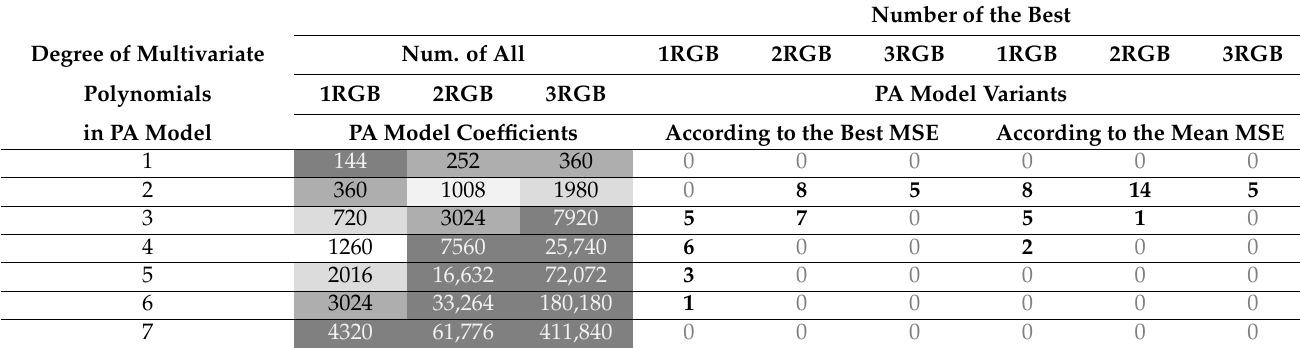
The number of parameters of 1HL ANN models for RS reconstruction increases according to formula 5, and of 2HL ANN models according to formula 6, where N in is the number of inputs, N HL 1 is the NoN in the 1st HL, N HL 2 is the NoN in the 2nd HL, and N out is the number of outputs or NoN in the output layer.